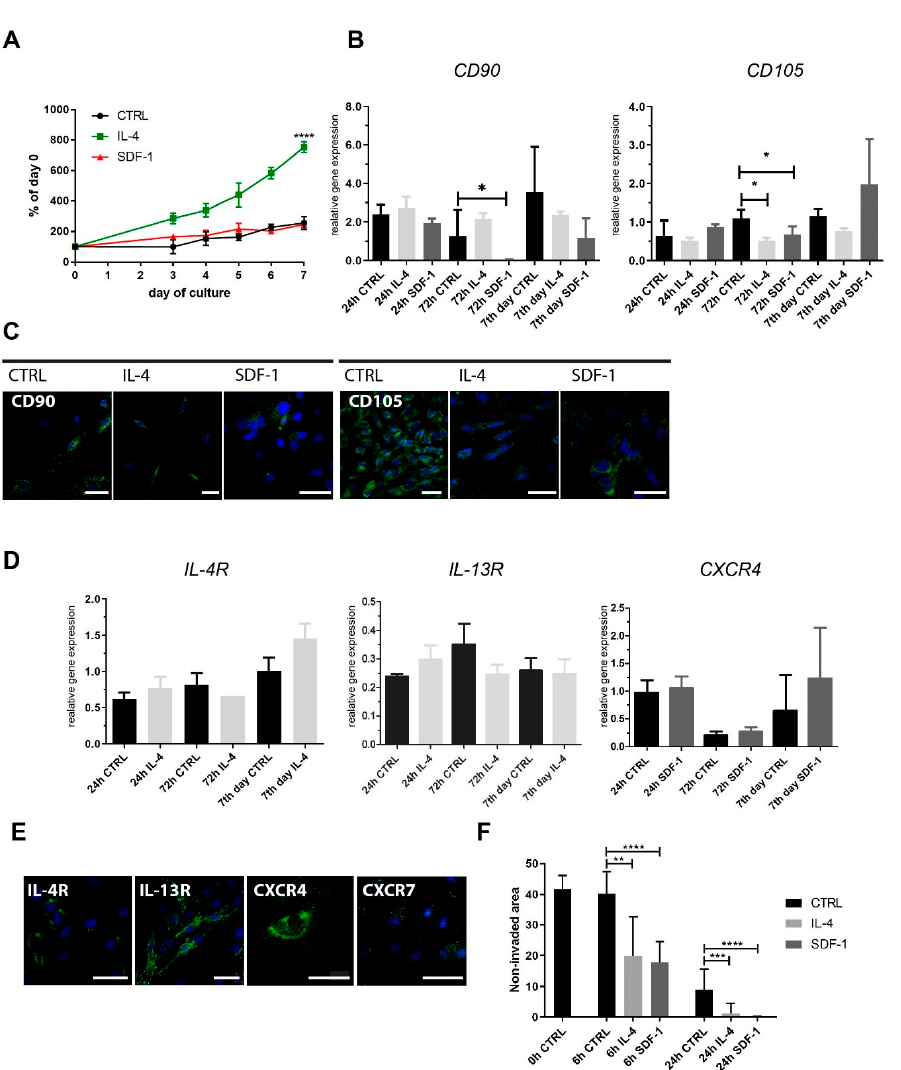
Figure 1. Characterization of rat adipose tissue-derived stromal cells (rADSCs) cultured under control conditions or in the presence of IL-4 or SDF-1. ( A ) Growth curves of rADSCs cultured for 7 days; ( B ) analysis of the level of mRNAs encoding CD90 and CD105. Expression was related to the levels observed in control cells at day 0 (beginning of the culture) and normalized to mRNA encoding HPRT; ( C ) localization of CD90 and CD105 (green) and nuclei (blue) in rADSCs. Bar: 50 µm. ( D ) Analysis of the level of mRNAs encoding IL-4R, IL-13R, and CXCR4. Expression was related to the levels observed in control cells at day 0 (beginning of the culture) and normalized to mRNA encoding HPRT; ( E ) localization of IL-4R, IL-13R, CXCR7, and CXCR4 (green) and nuclei (blue) in control cells. Bar: 50 µ m. ( F ) In vitro migration assay—rADSCs were scratched from a culture dish and the area that was not invaded by migrating cells was assessed (6 h and 24 h). N varied between 3 and 9. Data analyzed with Student’s t -test: 1A and D ( IL13-R ), data analyzed with Mann–Whitney U test: 1B, 1D ( IL-4R , CXCR4 ), 1F. Data are presented as mean ± SD. * represents results: * p ≤ 0.05; ** p ≤ 0.01, *** p ≤ 0.001, **** p ≤ 0.001. CTRL—non-treated